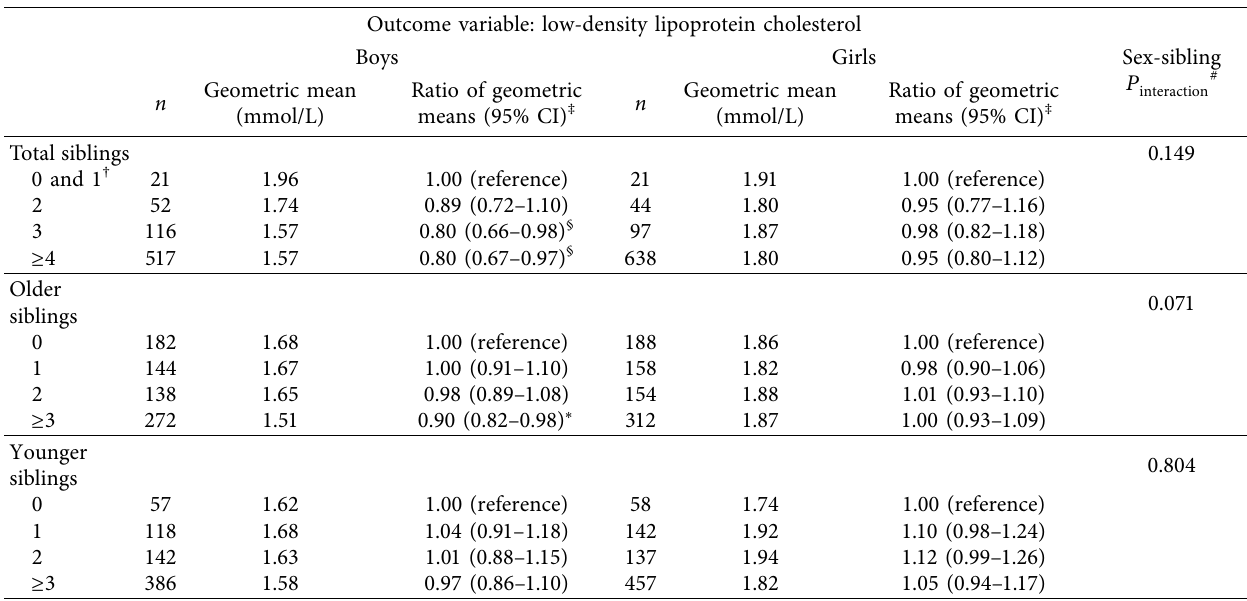
Table 3: Geometric means (GM) and adjusted ratio of geometric means of low-density lipoprotein cholesterol according to the total number of siblings, number of older siblings, and number of younger siblings stratified by